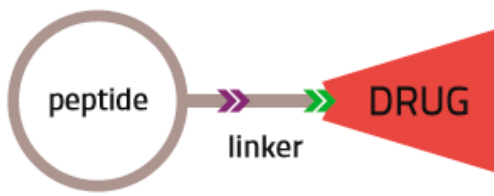
Figure 1. Schematic representation of PDC (peptide based drug conjugate).